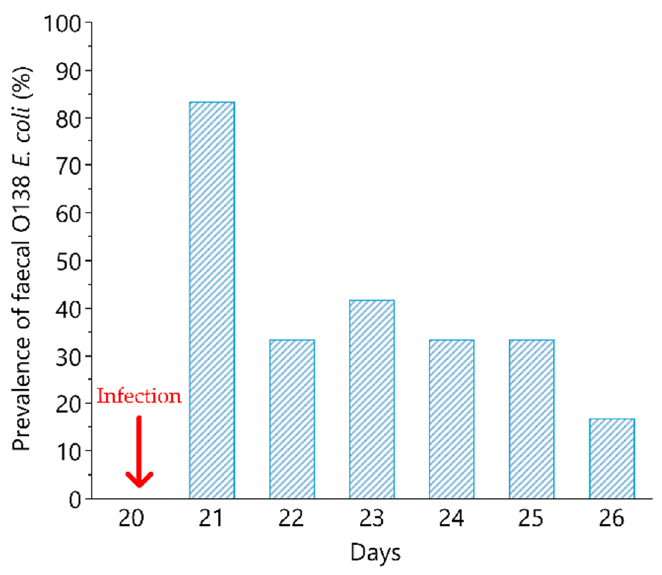
Figure 2. O138 F18 E. coli shedding after experimental pig infection. Percentage of piglets of the infected group ( n = 12) presenting O138 F18 E. coli in faeces in the post infection period (day 21 to day 28). The experimental infection was represented by a single intragastric inoculum (5 mL) equivalent to 1×10 10 O138 F18 E. coli colony-forming units (CFU)/5 mL and was performed at day 20. The arrow indicates the day of infection.